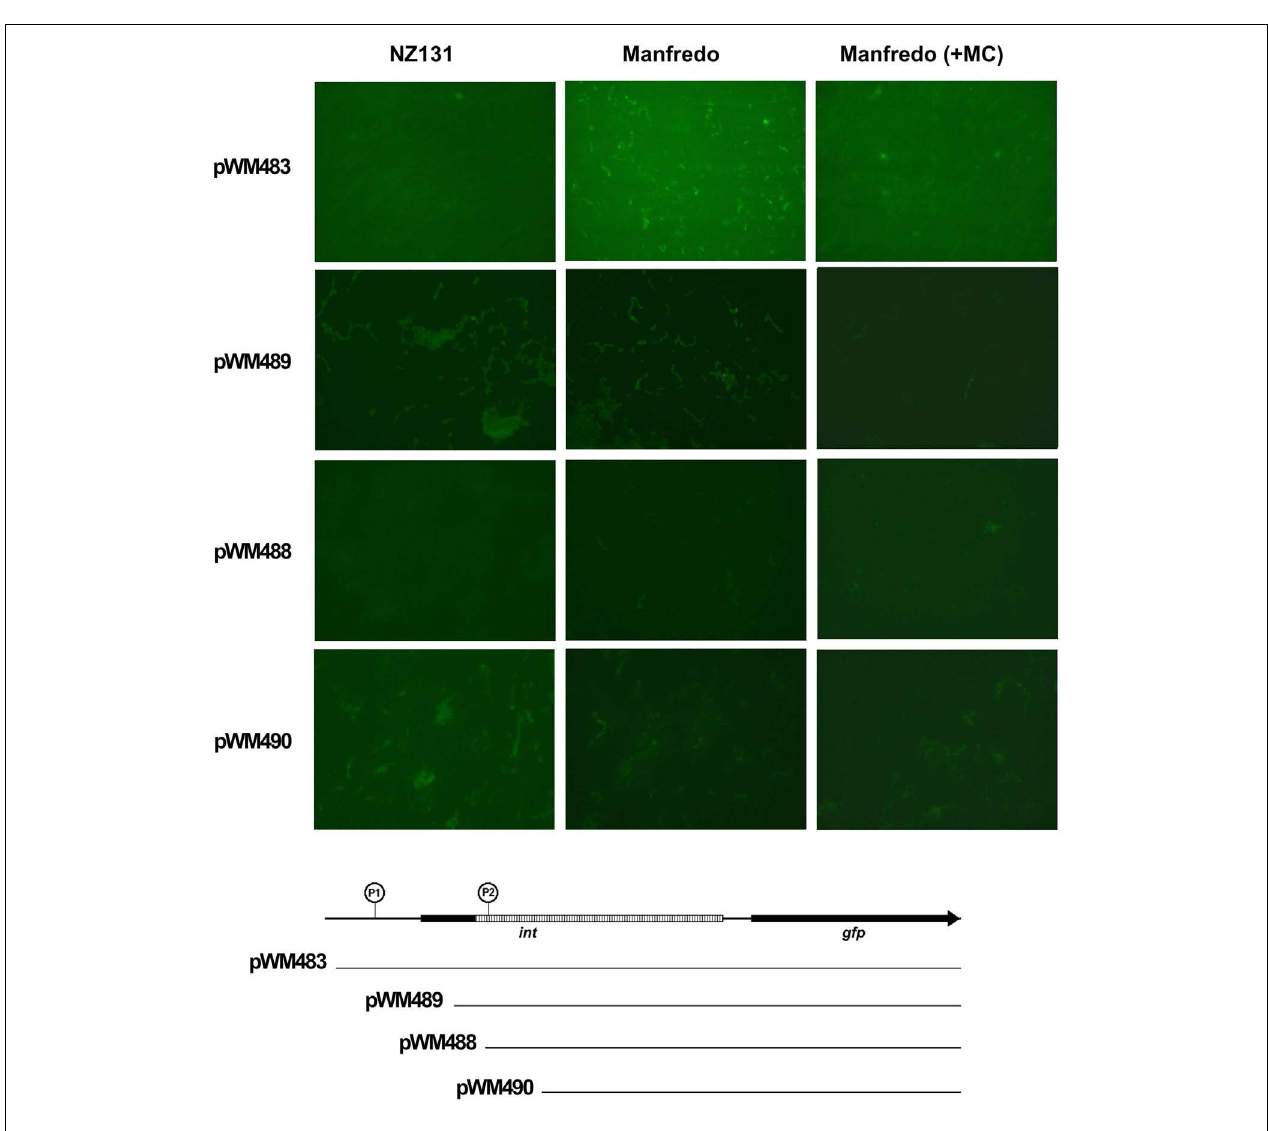
indicates the predicted promoters (Reese, 2001). P1 is immediately upstream of the beginning of the int ORF, while P2 is positioned within the pseudogene and maps to the beginning of transcription ( Figure 6 ).The plasmids with these constructs were introduced into strains NZ131 and Manfredo (SpyCIM5 + ). In E. coli JM109, no GFP fluorescence could be detected for any plasmid (not